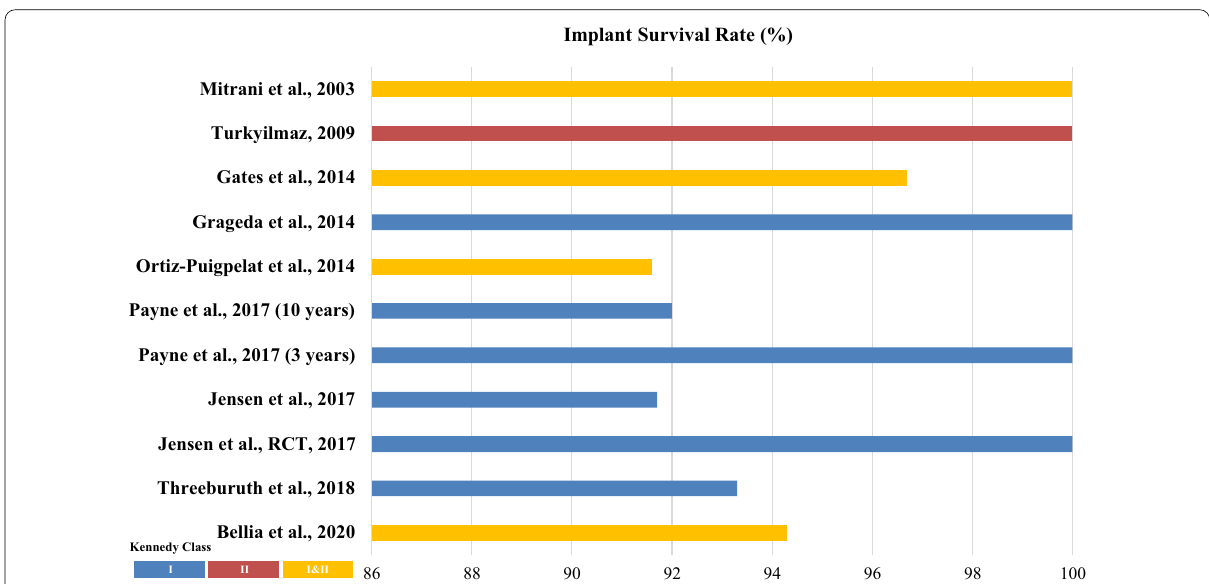
Fig. 2 Comparison of the implant survival rate in the included studies based on Kennedy’s classification of the study samples [*Payne et al. reported the survival rates for 3 years and 10 years, separately